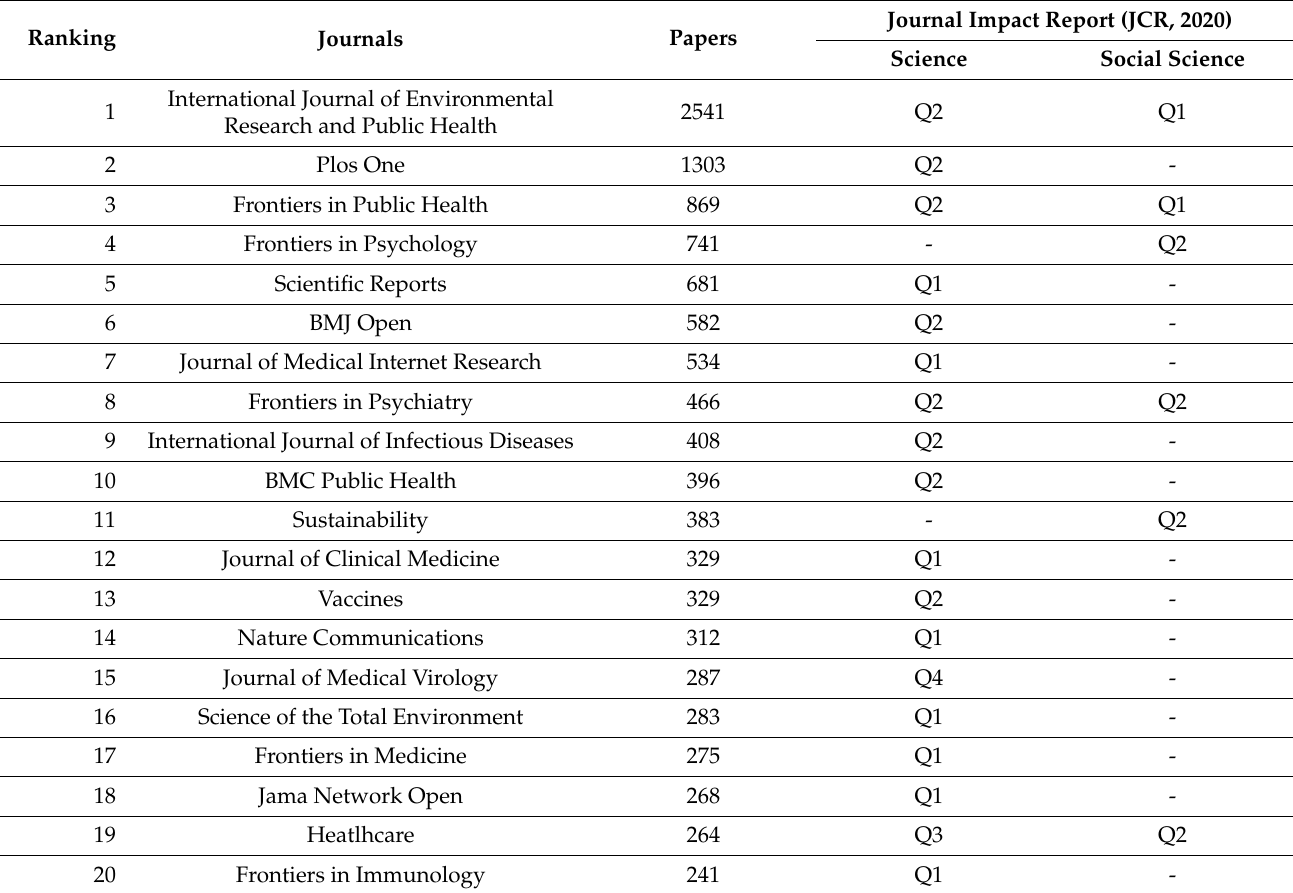
Table 3. Ranking of leading journals with publications on COVID-19 and Health.